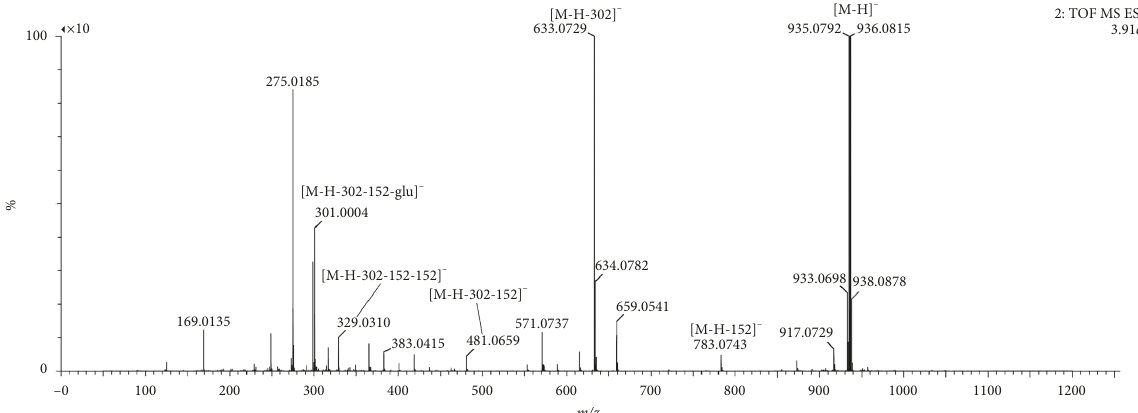
Figure 5: The MS 2 spectra and fragmentation pathway of mono-O-ellagic-tri-O-galloyl